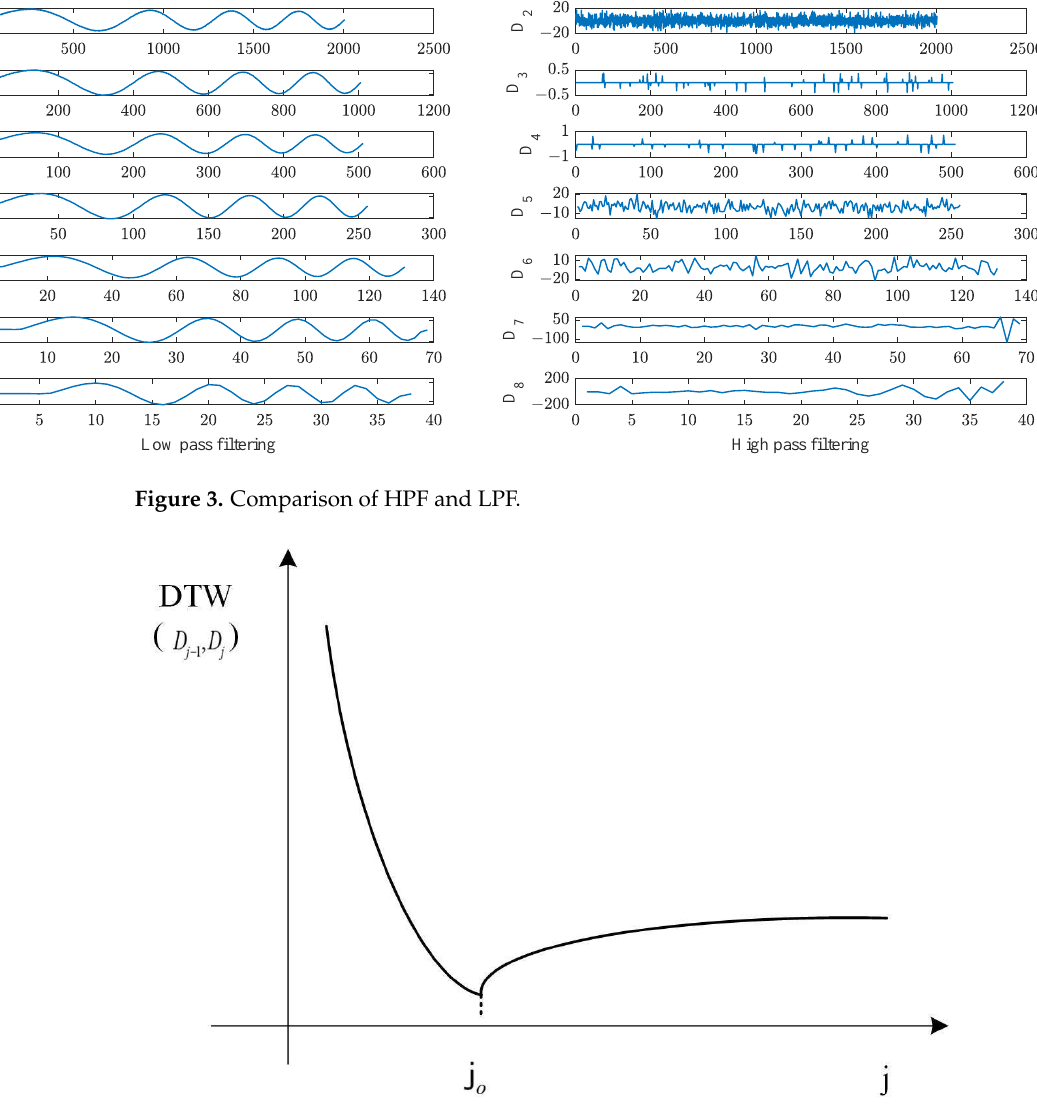
Figure 4. The relationship between DTW distance and decomposition